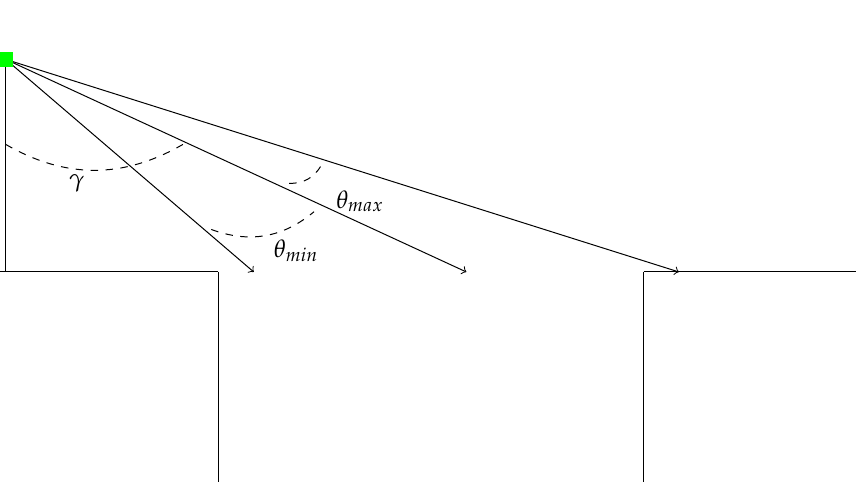
Figure 2. Depiction of the sensor mount angle, γ and the sensor limit function. Lidar sensors also have a finite range. In order to account for the limits of the sensor range R , the following calculation is only valid on the range x = [ x 0 , x 1 ] , where